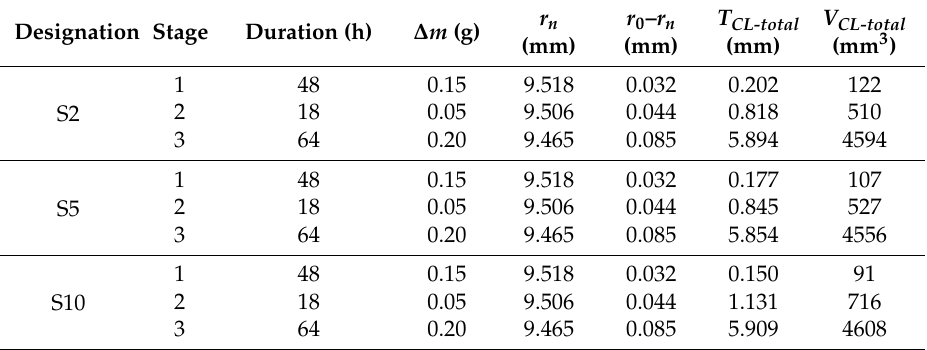
Table 5. Corrosion induced volume expansion.